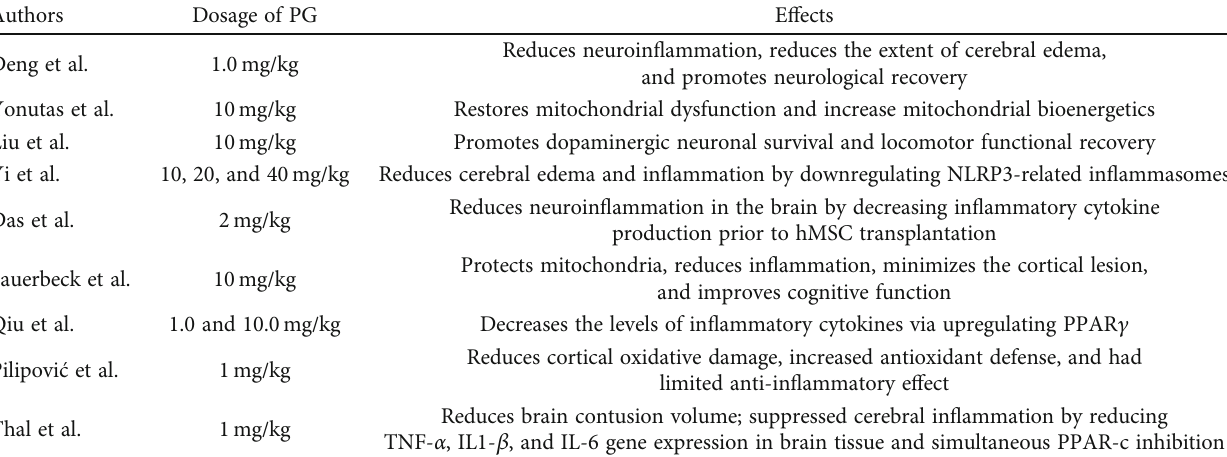
Figure 1: E ff ects of TBI types on the brain. Table 1: Studies consistent with the purpose of this